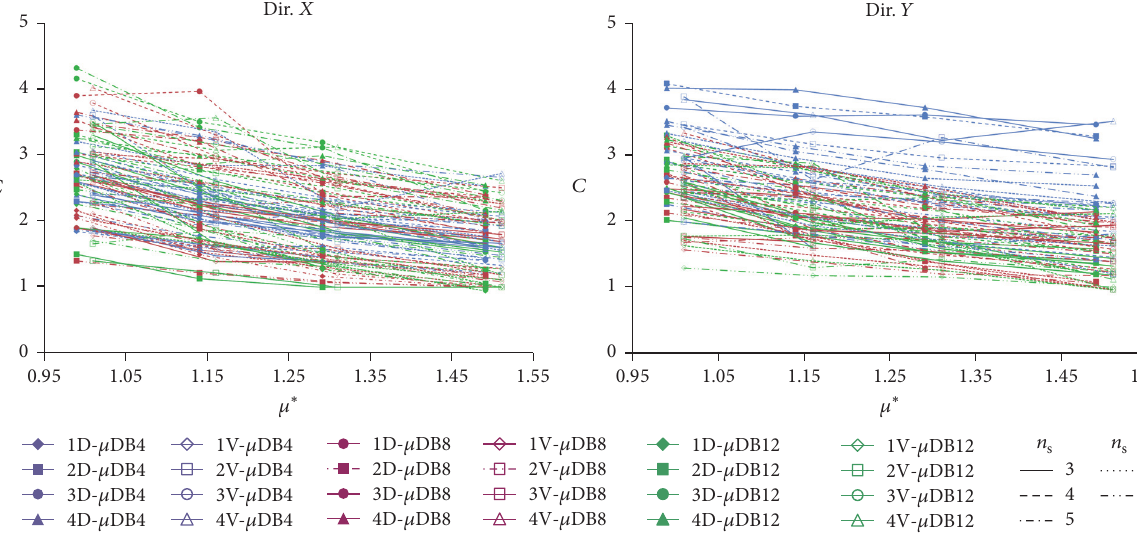
Figure 13: Correlation between 𝐶 and design structural ductility 𝜇 ∗